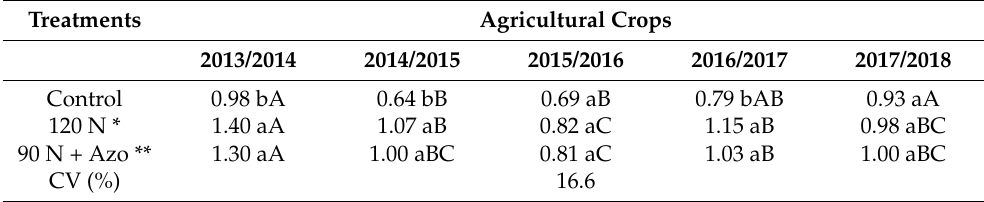
Table 8. Amount of nitrogen exported by the grains of rice plants (%) as a function of treatments with and without nitrogen and combined with Azospirillum brasilense . Average of four repetitions.